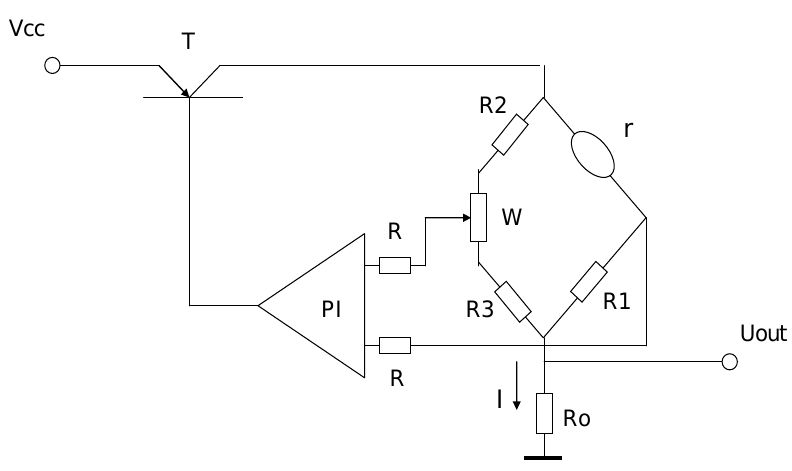
Figure 4. Constant temperature detection